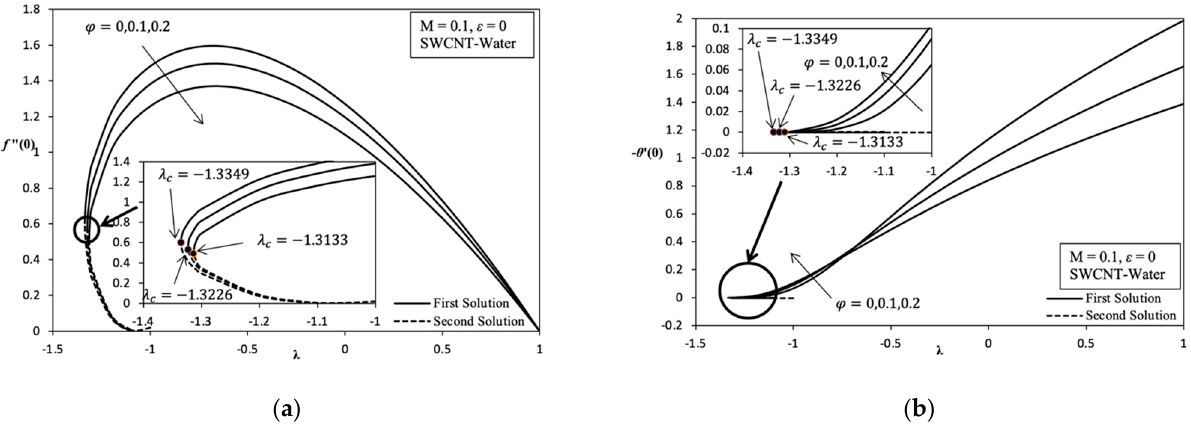
Figure 6. Variation on 𝜆 with various values of 𝜑 in SWCNT-water when 𝑀 = 0.1: ( a ) Variation on f ″ (0); ( b ) Variation on − 𝜃 ′ (0).